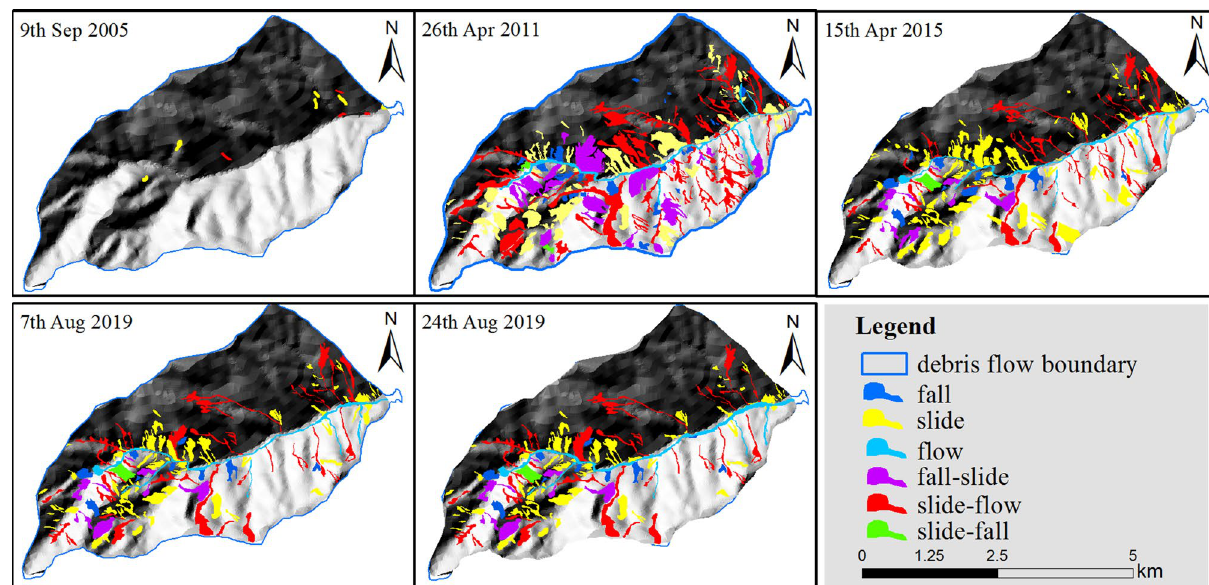
Figure 10. Multiphase provenances distribution map of Chediguan Gully. Maps constructed using ArcGIS 10.2 (https:// deskt op. arcgis. com/ en/).